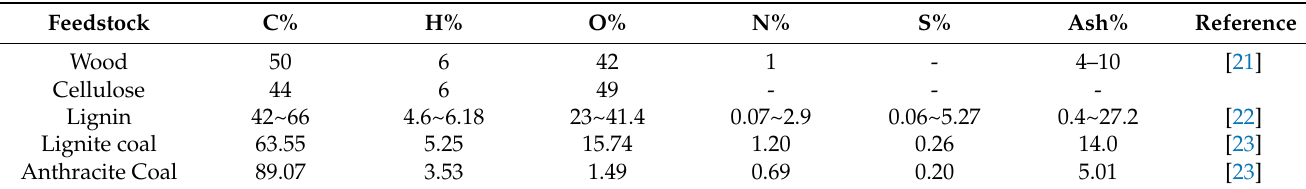
Table 1. Elemental compositions of wood, cellulose, lignin, and coal.